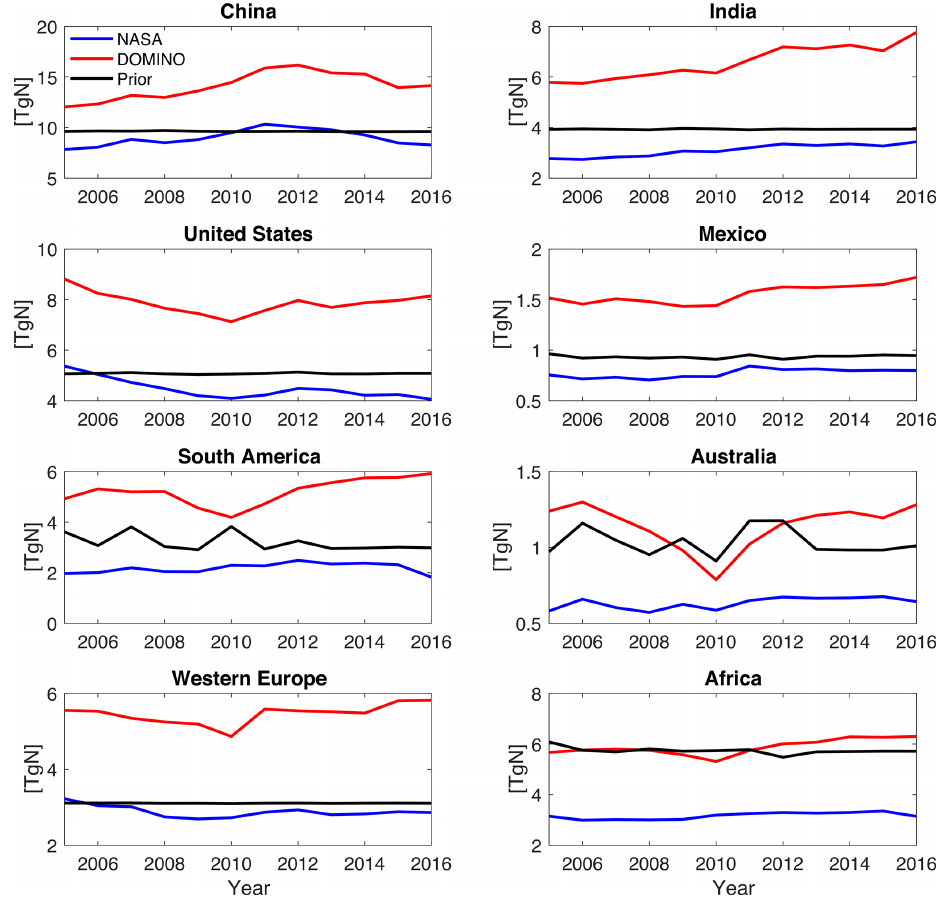
Figure 6. Annual total posterior NO x emissions from 2005 to 2016. The black lines show prior total NO x emissions from bottom-up inventories, which use HTAP anthropogenic emissions in 2010 for all years. The blue lines represent the emissions constrained by the OMI NO 2 NASA product. The red lines represent emissions constrained by the OMI NO 2 DOMINO